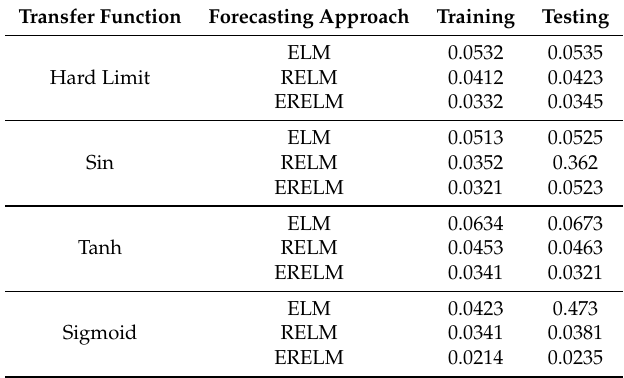
Table 9. Obtained RMSE using ELM, RELM and ERELM.